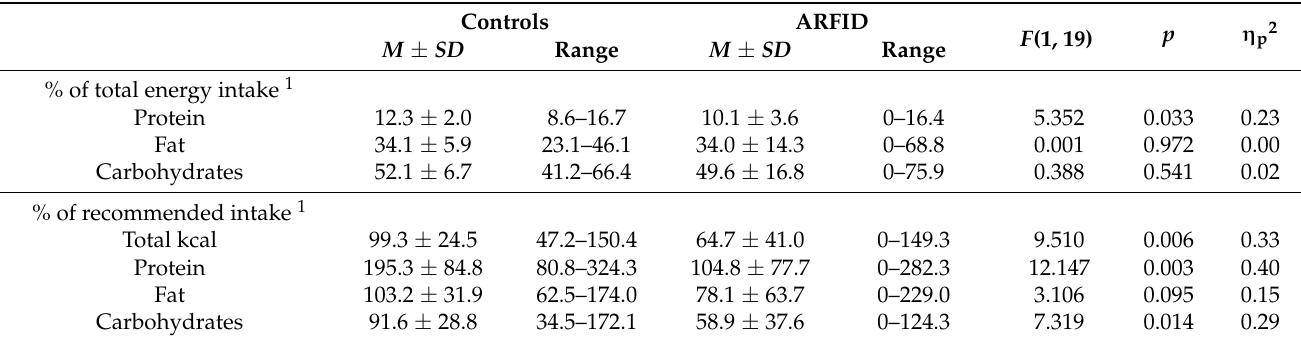
Table 1. Total energy consumed from protein, fat, and carbohydrates and achieved percentage of recommended energy and macronutrient intake in avoidant/restrictive food intake disorder (ARFID) and controls.